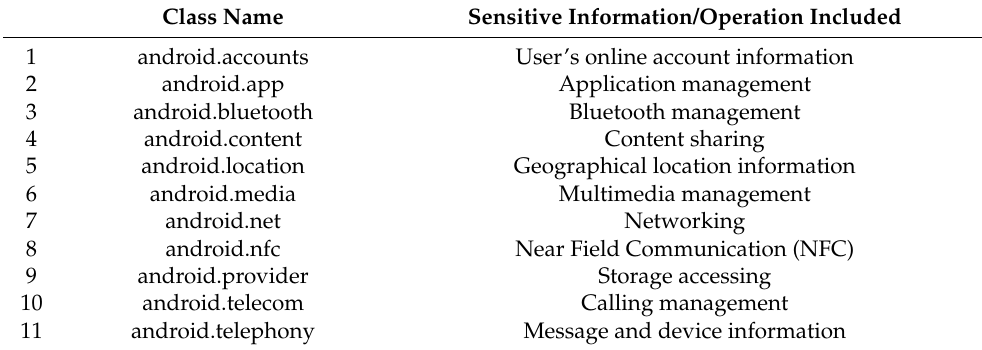
Table 1. 11 Android sensitive class packages.